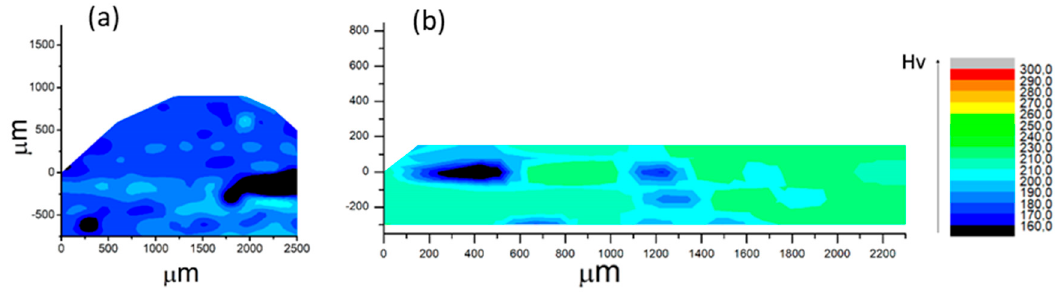
Figure 8. Micro Vickers maps of ( a ) circular overlap samples built with 300 W, 70% overlap and S2; ( b ) circular with overlap samples built with 300 W, 50% overlap and S2.